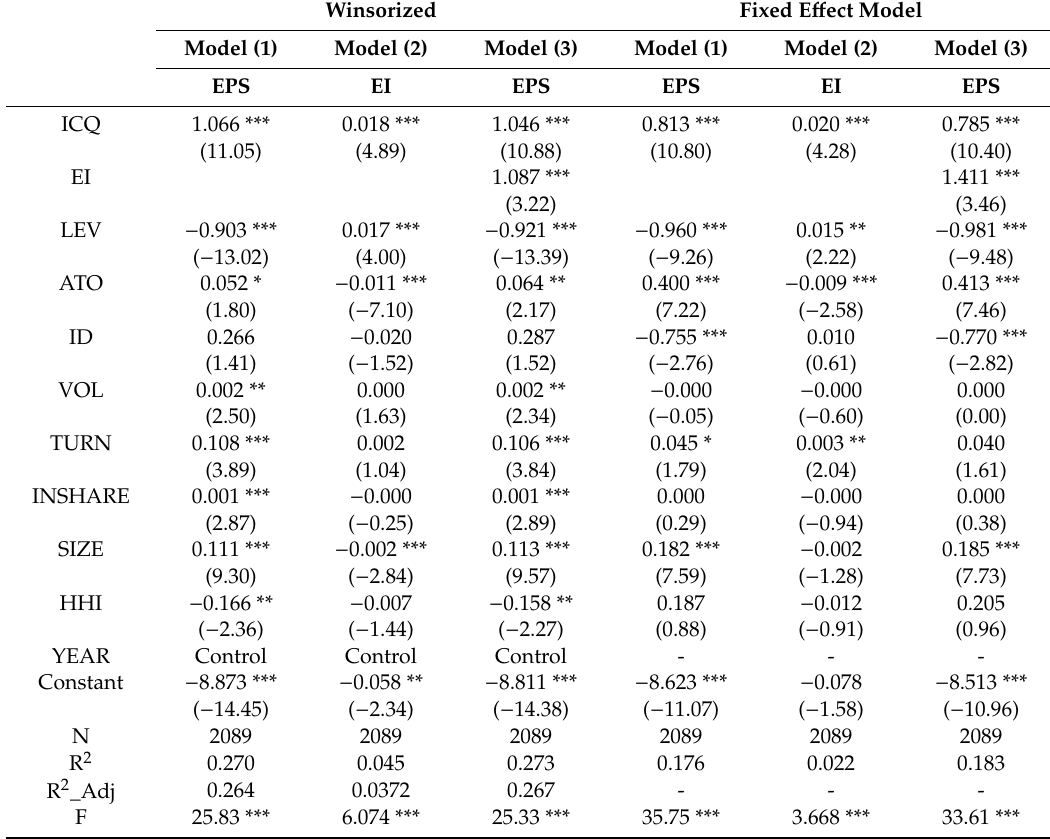
Table 6. Robustness test (Winsorize treatment and fixed e ff ect